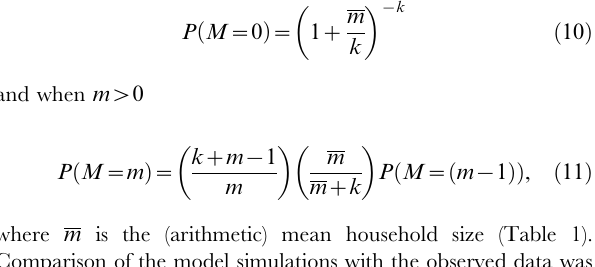
Table 1. Demographic and prevalence data from the four populations examined for ocular Chlamydia trachomatis .